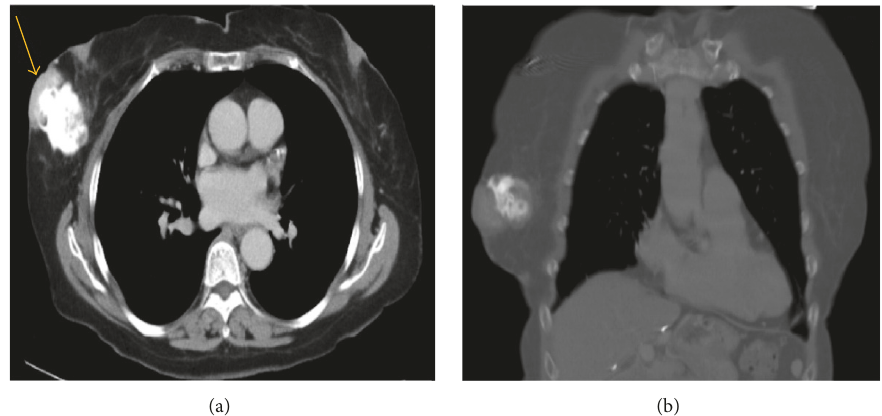
Figure 4: Axial (a) and coronal (b) contrast-enhanced CT to characterize the lesion and rule out metastasis. A heavily calcified right breast mass was noted measuring about 3.2 × 5.8 cm with overlying skin thickening.